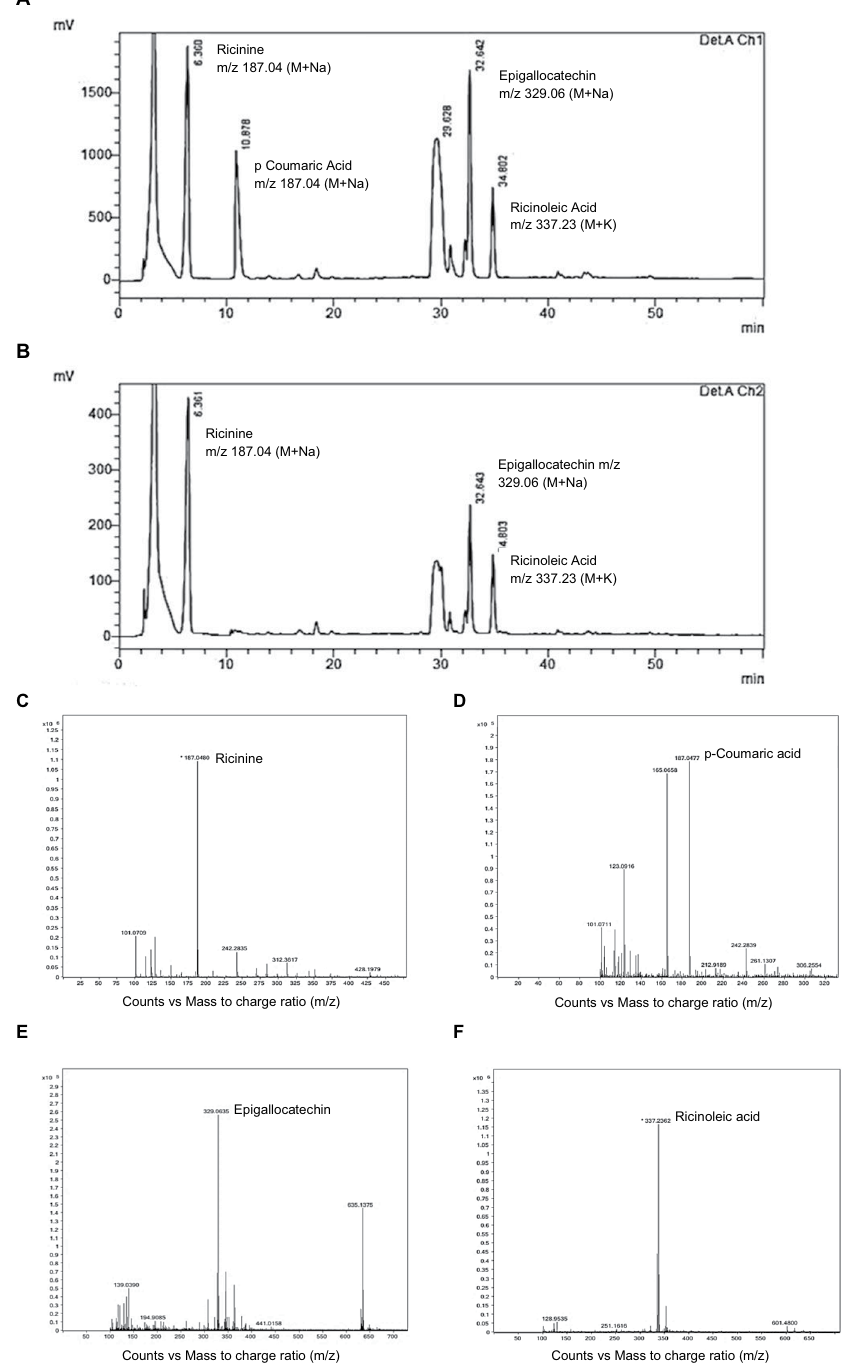
Figure 6. Fingerprint analysis of ethyl-acetate fraction of RCFE. RP-HPLC chromatogram of the ethyl-acetate fraction at a wavelength of ( A ) 210 nm (Det A Ch1) and ( B ) 254 nm (Det B Ch2). ESI-MS spectra of fractions collected after RP-HPLC were identified as Ricinine ( C ), p-Coumaric acid ( D ), Epigallocatechin ( E ) and Ricinoleic acid ( F